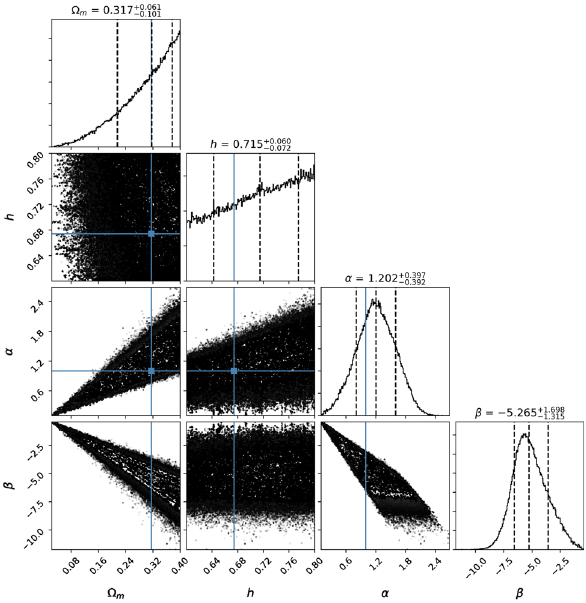
Fig. 3 MCMC simulation results for the second toy model’s, with n = 0, cosmological parameters ( Ω m , ¯ h ), as well as the model’s arbitrary free parameters ( α and β ). The “true” values for Ω m and ¯ h (blue lines) are provided by Planck 2018 collaboration data release [7]. We used 100 random walkers and 10,000 iterations. The blue lines for arbitrary free parameter values are to show their initial chosen starting point for the MCMC simulation